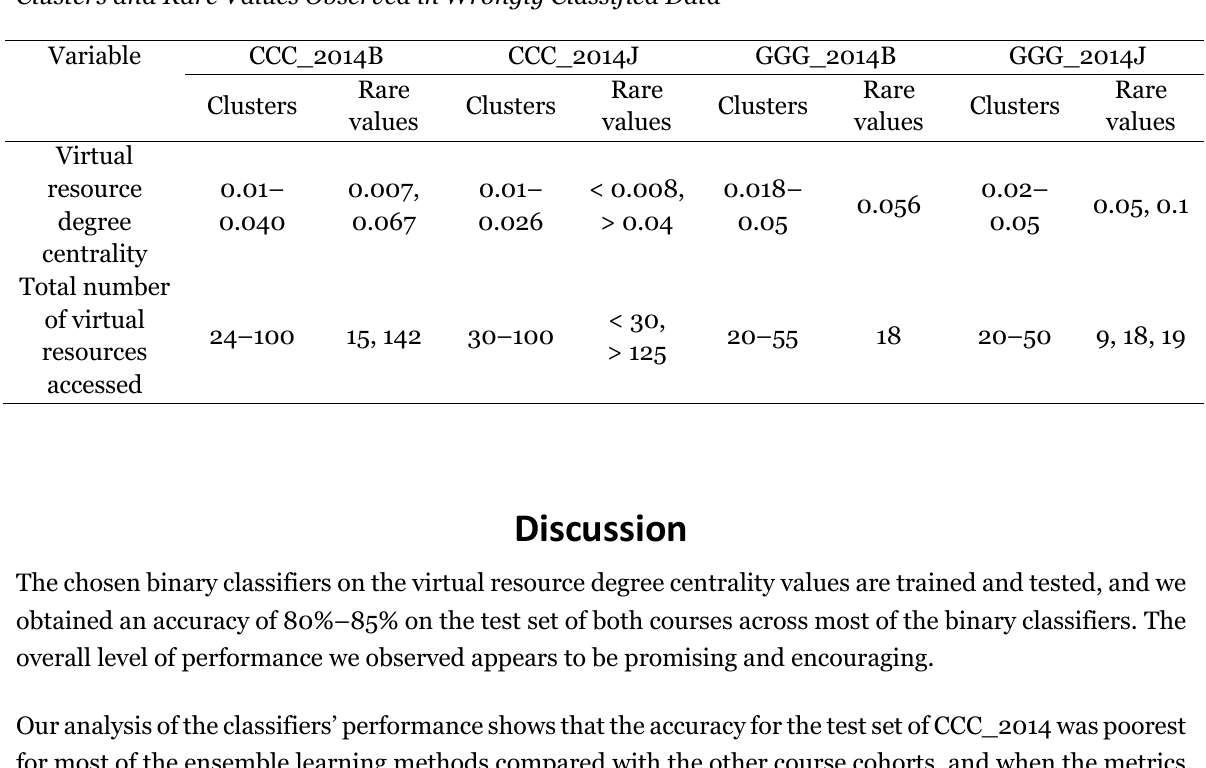
Clusters and Rare Values Observed in Wrongly Classified